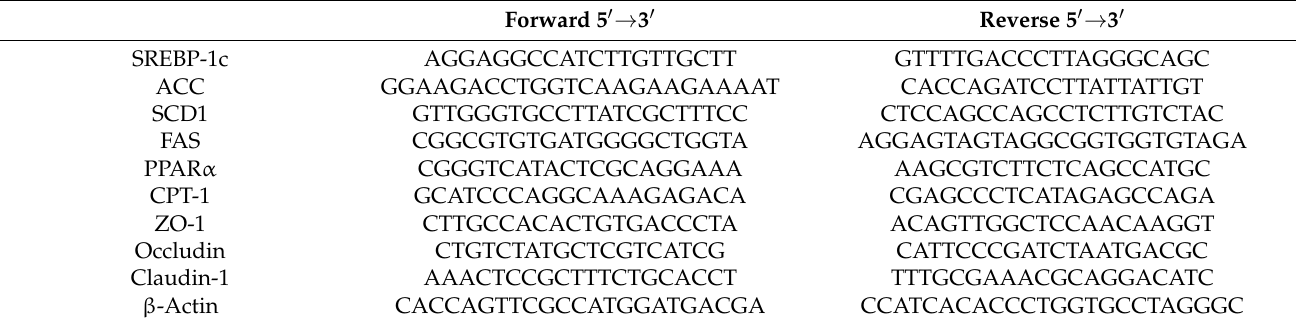
Table 10. Primers used for the quantitative polymerase chain